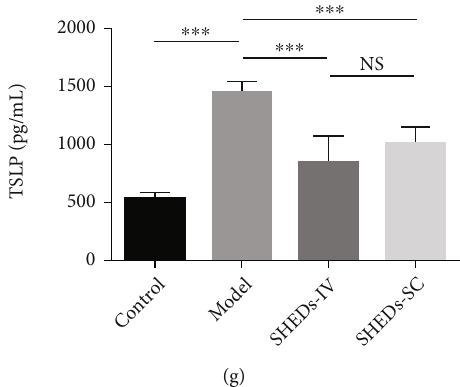
Figure 4: E ff ect of SHEDs on AD-related immunoglobulin and cytokine expression in serum and skin tissue. (a – c) The immunoglobulin levels of IgE, IgG1, and IgG2a in serum. (d – g) The cytokine levels of TNF- α , IL-4, IL-17A, and TSLP in serum. All the data are expressed as mean ± SD ( n = 6 ). Three repeated times of each experiment were conducted.